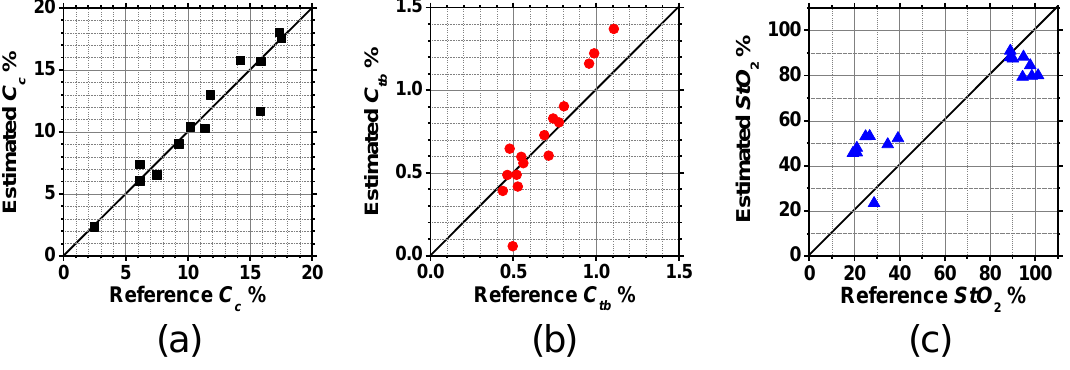
, ( b ) C , and ( c ) StO in the phantom c tb 2